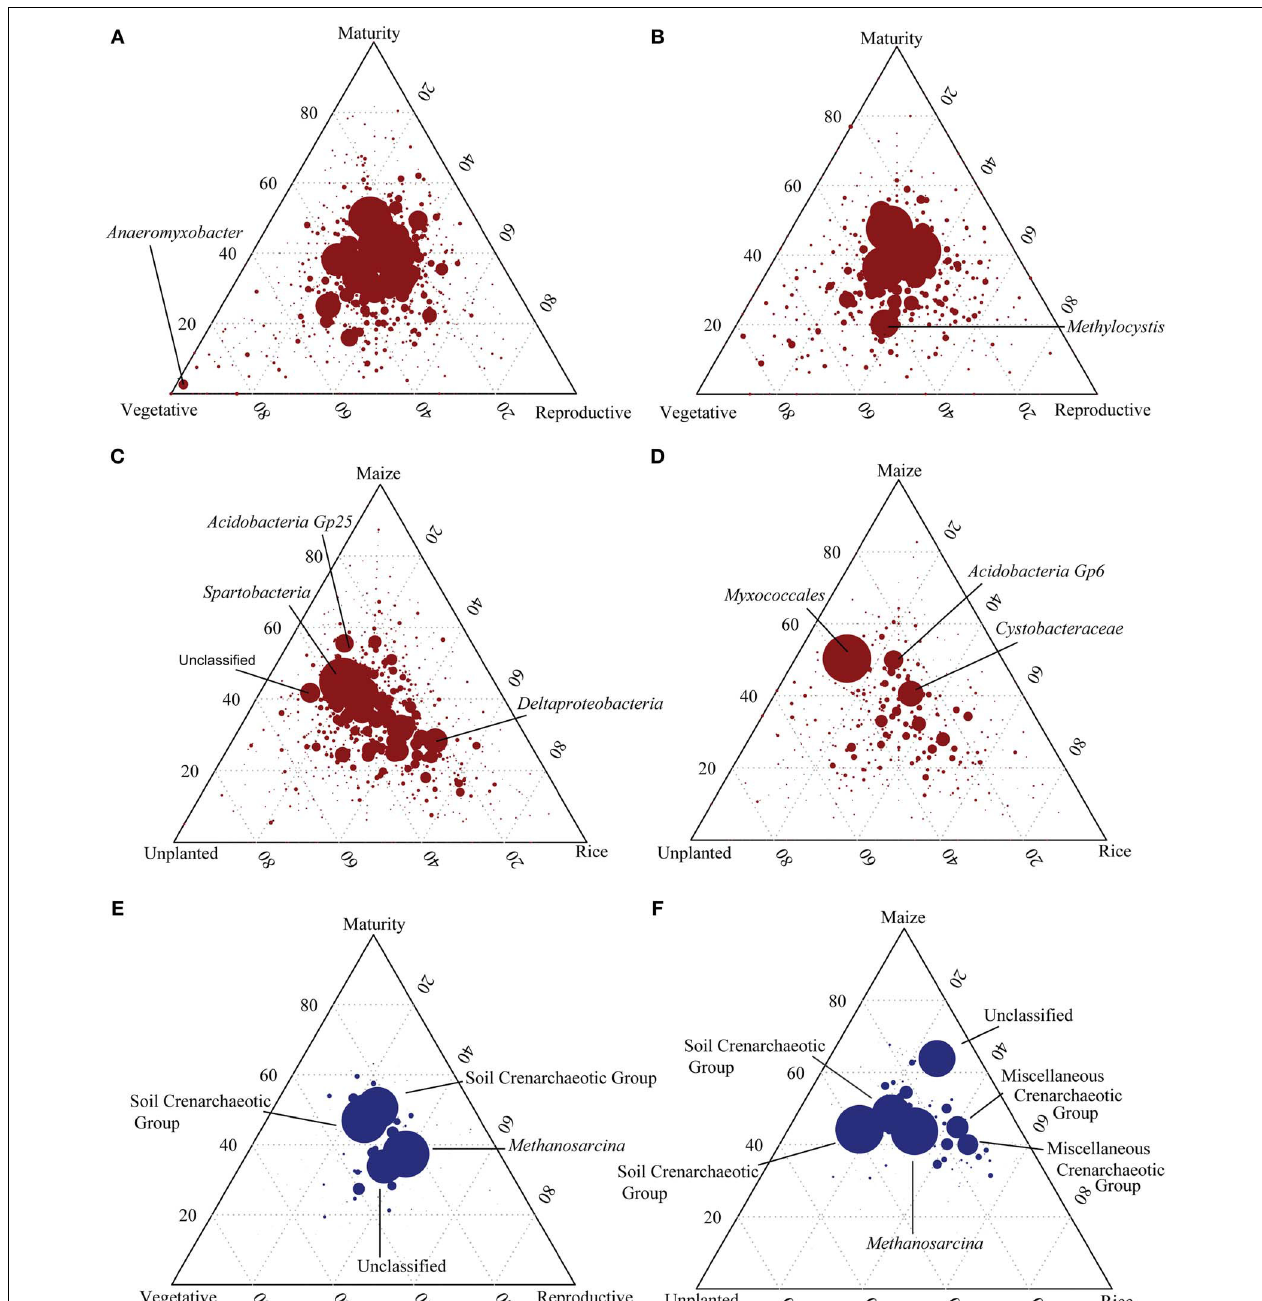
FIGURE 5 | Ternary plots showing the distribution of bacterial and archaeal 16S rDNA and rRNA based OTUs. Axes represent rice plant growth stages (vegetative, reproductive and maturity) (A,B,E) as well as unplanted and maize cultivated fields in comparison to rice cultivated fields (C,D,F) and the percentage of reads associated with each sample for each